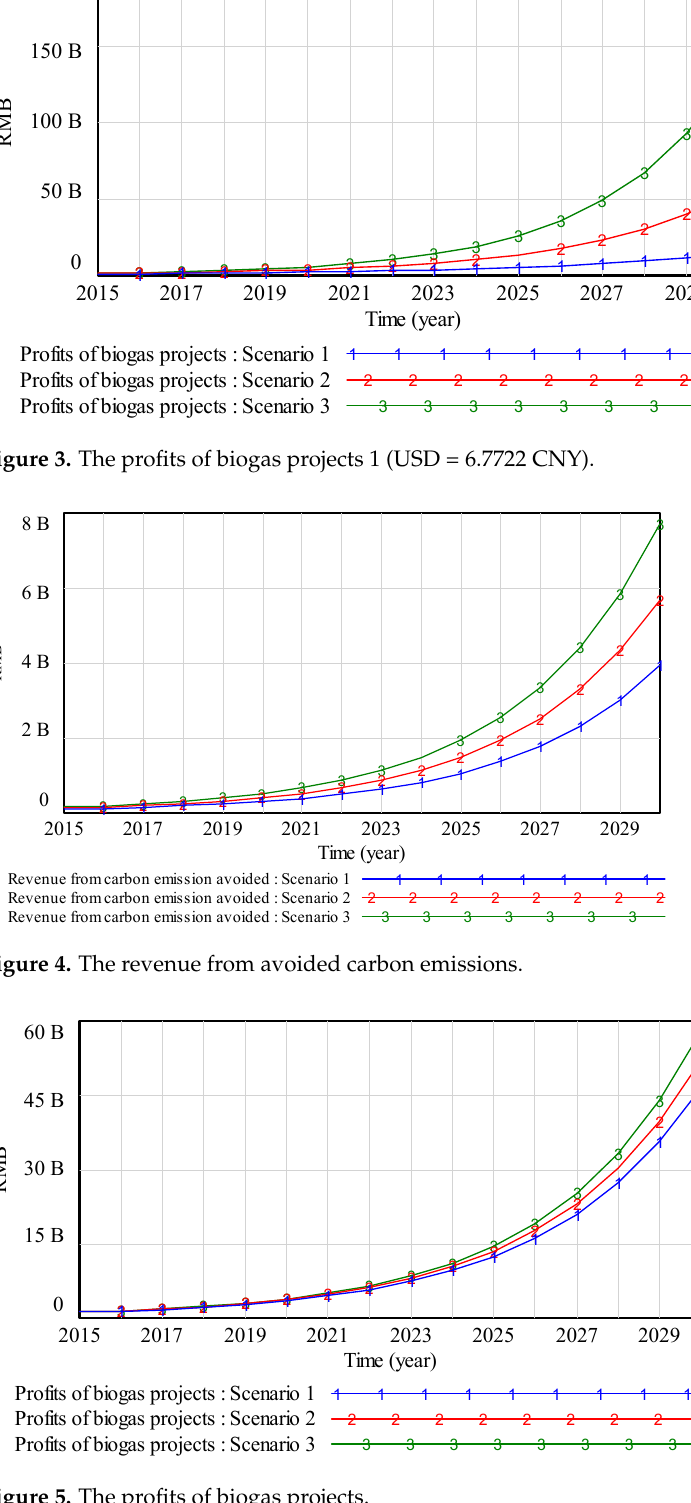
Figure 3. The pro fi ts of biogas projects 1 (USD = 6.7722 CNY).